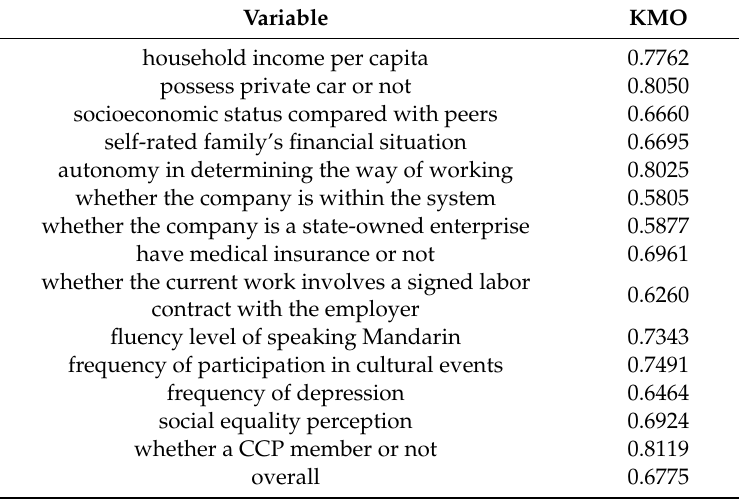
Table 6. The KMO (Kaiser-Meyer-Olkin) value of